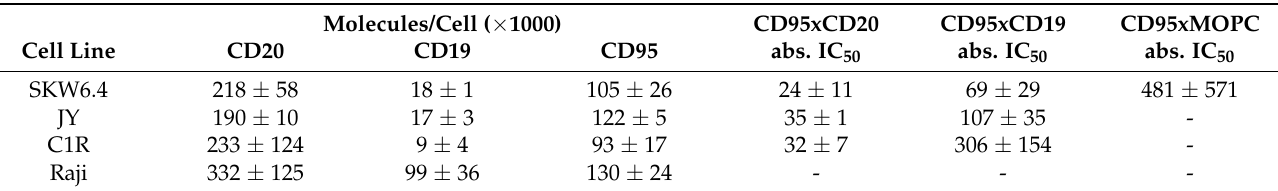
Table 1. Antigen expression on lymphoma cell lines and IC 50 values of bispecific antibodies. The number of CD20, CD19, and CD95 molecules expressed on different lymphoma cell lines (see also Figure 2a) as well as the absolute IC 50 values (pM) of different bispecific antibodies (see also Figure 2b). Mean ± SD, n =